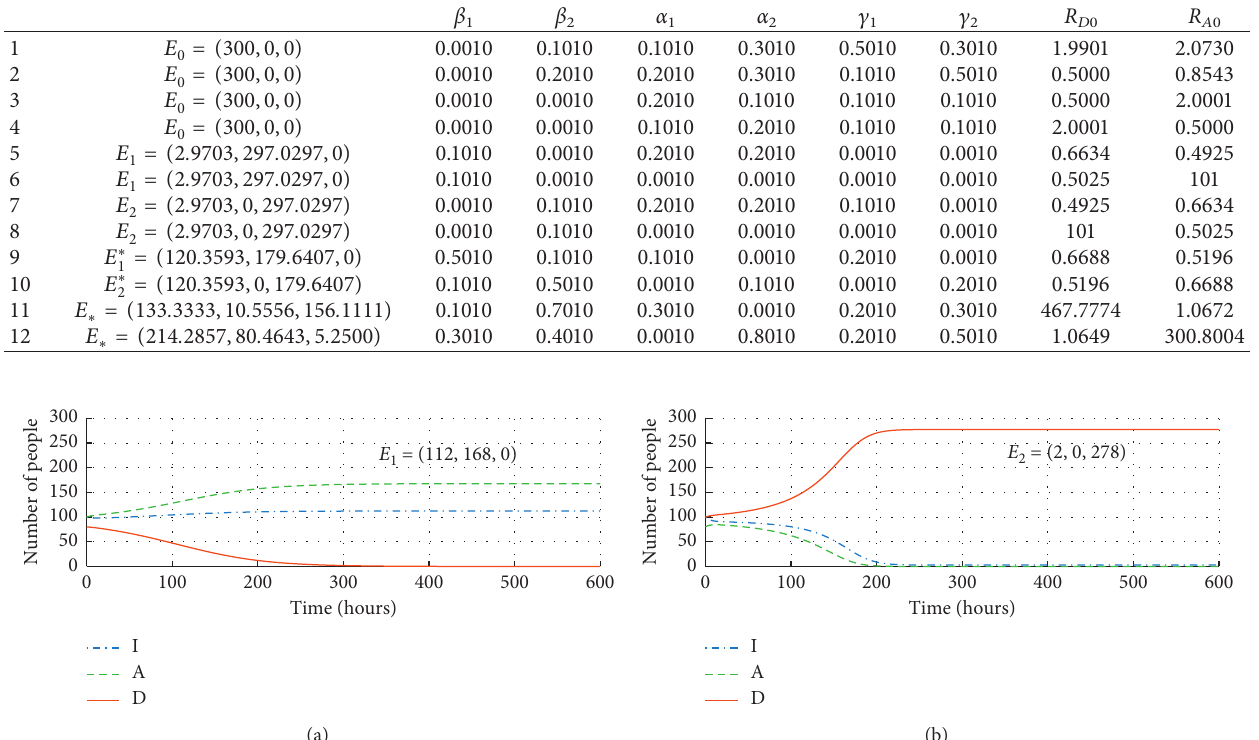
Table 3: Steady states and parameters’ values used in example simulations, where I ( 0 ) � A ( 0 ) � D ( 0 ) � 100.